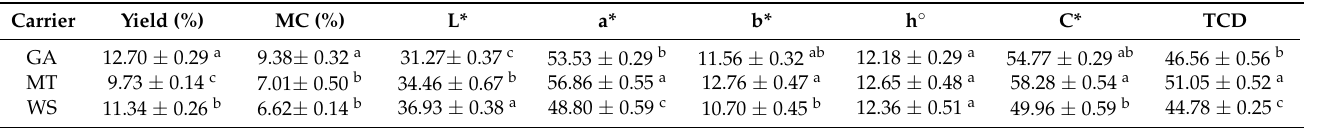
Table 1. Yield, MC, and colour attributes of raspberry juice freeze-dried powders obtained with different